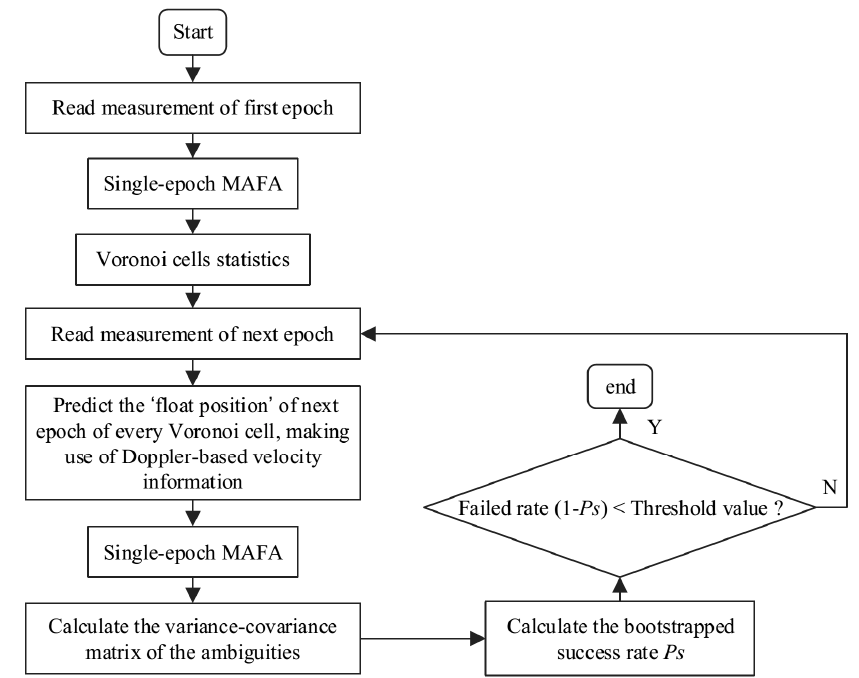
Figure 1. Illustration of the Voronoi cell in 2D.